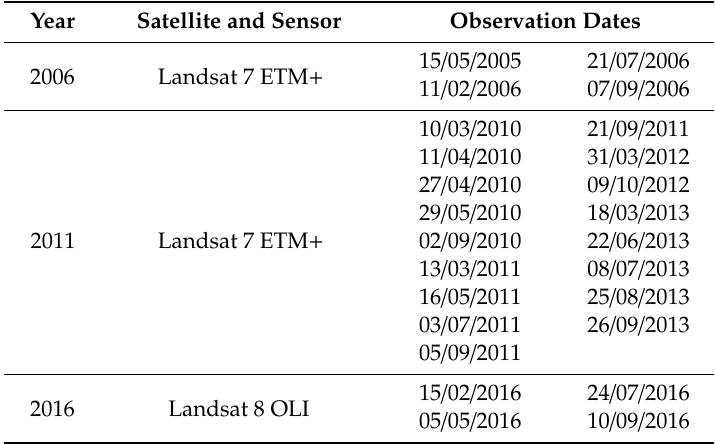
Table 1. Observation dates of Landsat in three